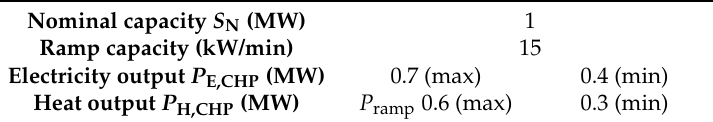
Table A2. Technical parameters of